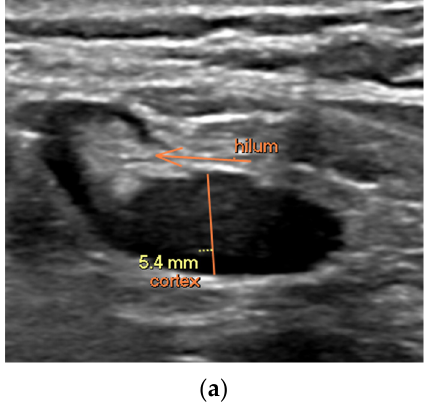
Figure 2. ( a ) Ultrasonographically highly suspicious axillary lymph node with a focal eccentric cortical thickness of 5.4 mm, displaced fatty hilum and subtle cortical microlobulation, confirmed malignant post-FNAB. ( b ) Schematic representation of the node demonstrating a displaced fatty hilum (yellow), diffuse cortical thickening (blue) and eccentric metastatic deposit (purple).